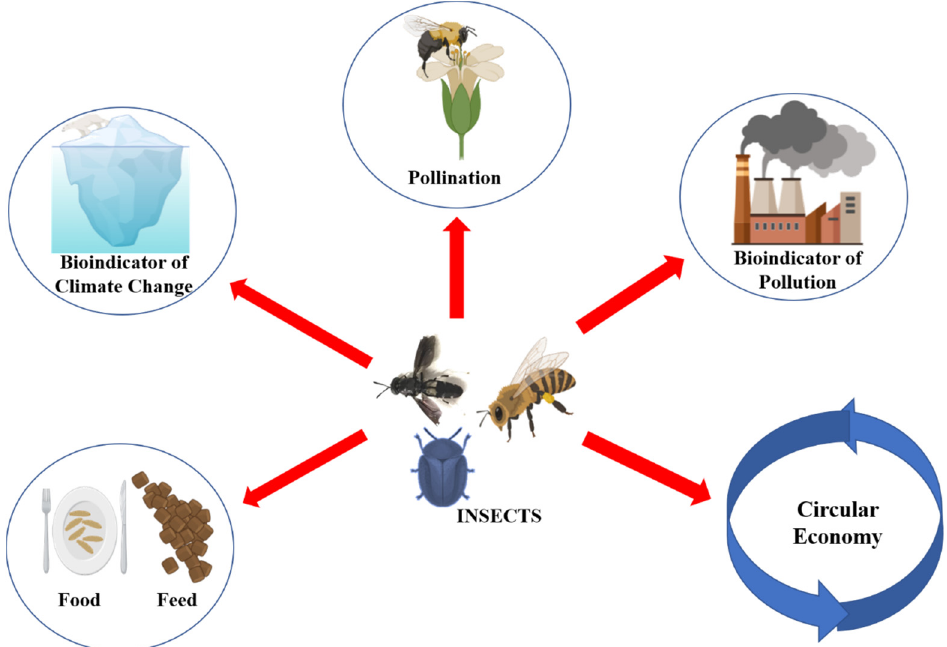
Figure 1. Insects play a key role in ecosystem functions maintenance. They are the key pollination agents of most crops and wild vegetation and find a role in the circular economy. Moreover, they are bioindicators of climate change and pollution and find applications in feed and food. Table 1. Lipid yield and fatty acid compositions in seven insect species that could be to be reared for feed production for aquaculture, poultry, and pig farming according to European Regulations 873/2017 and 2021/1372 and some plant oil. DW = dry